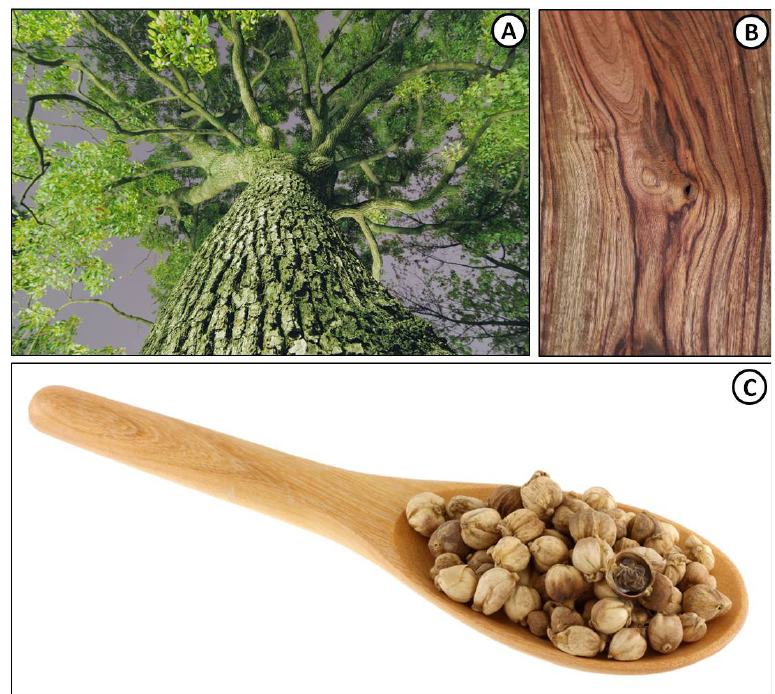
Figure 1. Cinnamomum camphora tree, wood and